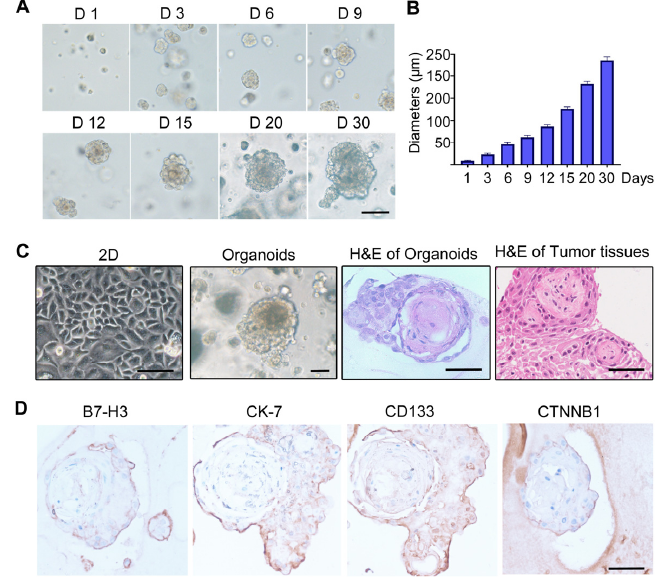
Figure 5. Establishment of 3D organoid in vitro cultures of craniopharyngioma. ( A ) Morphology of craniopharyngioma organoids at different time points. Scale bar: 100 μ m. ( B ) Semi-quantitative analysis of organoid size. ( C ) Representative images of 2D culture of primary isolated CP cells, 3D organoids, and H&E staining of CP organoids and clinical tumor tissues. ( D ) IHC staining of B7-H3 and CP markers of the organoids. Scale bar: 100 μ m.